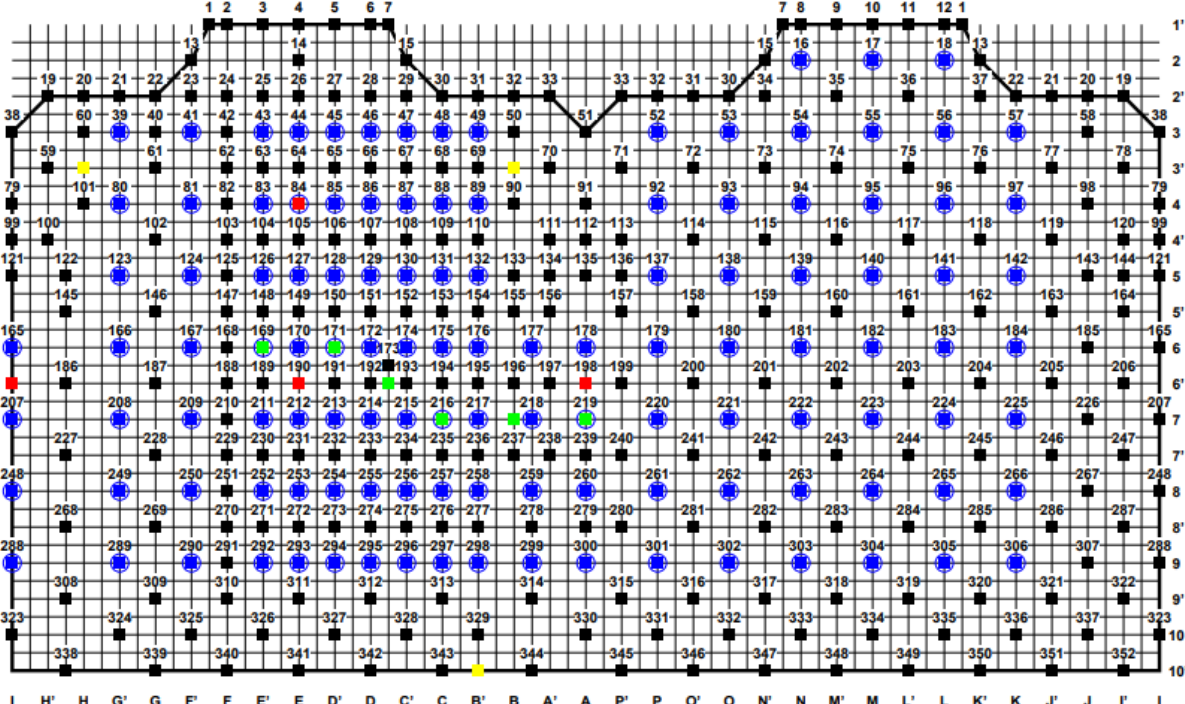
Figure 1. Body surface potential map. Symbols after letters represent column numbers, while symbols after numerals represent row